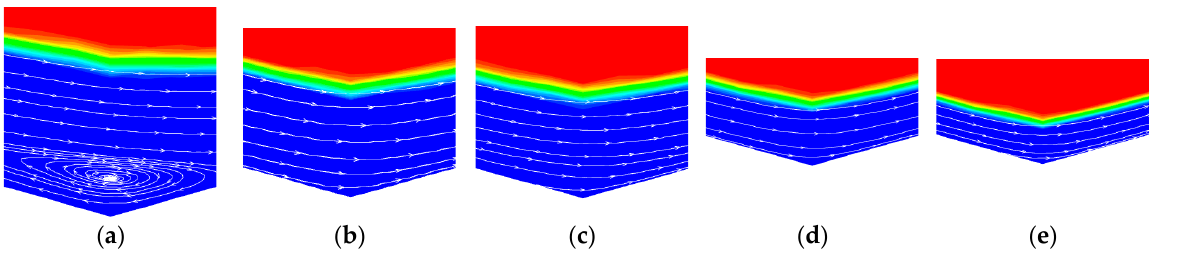
Figure 8. Streamline on the triangular corrugated plate for different fluids: ( a ) water ( T in = 25 °C); ( b ) water ( T in = 37 °C); ( c ) seawater; ( d ) R290; and ( e ) O 2 .